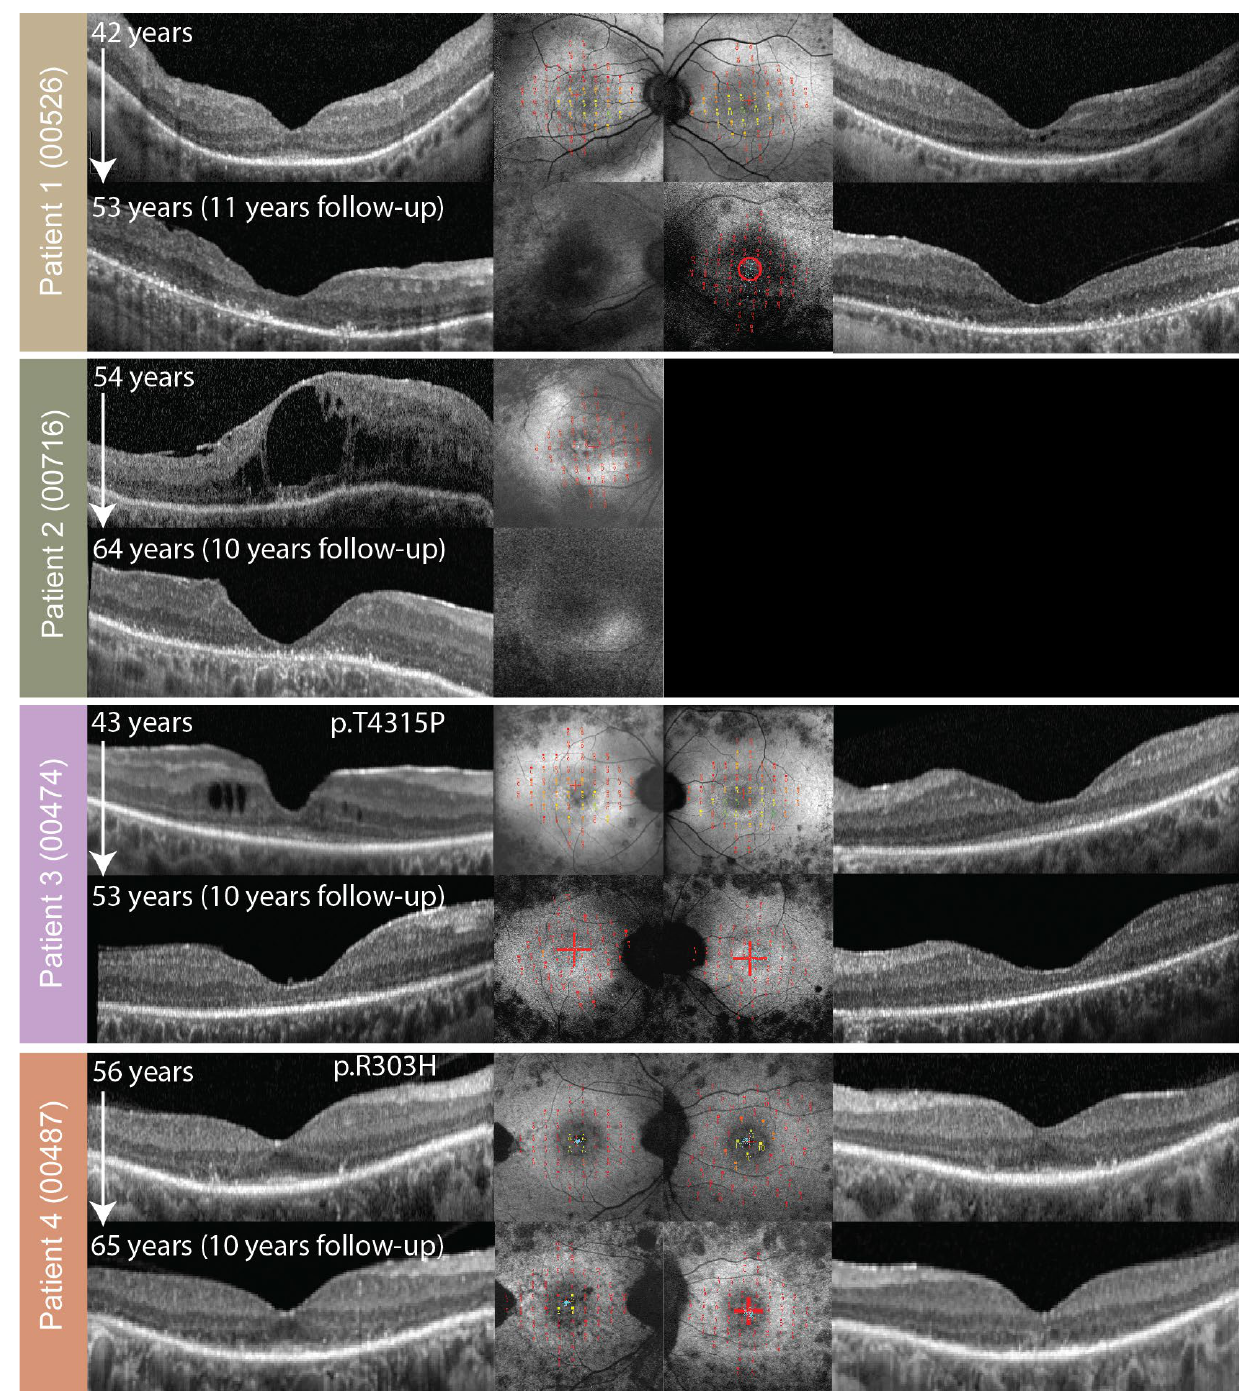
Figure 3. OCT (side columns) and FAF with overlaid microperimetry (the central two columns) of patients 1–4. The right eye is shown on the left and the left eye on the right. Patient ID (center ID) is stated on the left side. Follow-up images are shown if available. Patient 2 had undergone enucleation of the left eye for unrelated reasons. Microperimetry is on a color scale from good sensitivity (green) to poor retinal sensitivity (red). Fixation points are marked with blue dots. Note good retinal sensitivity inside the hyperautofluorescent ring in patients with this FAF pattern (patients 1, 3, and 4) and loss of retinal sensitivity with progression to the hyperautofluorescent patch on follow-up (patients 1 and 3).